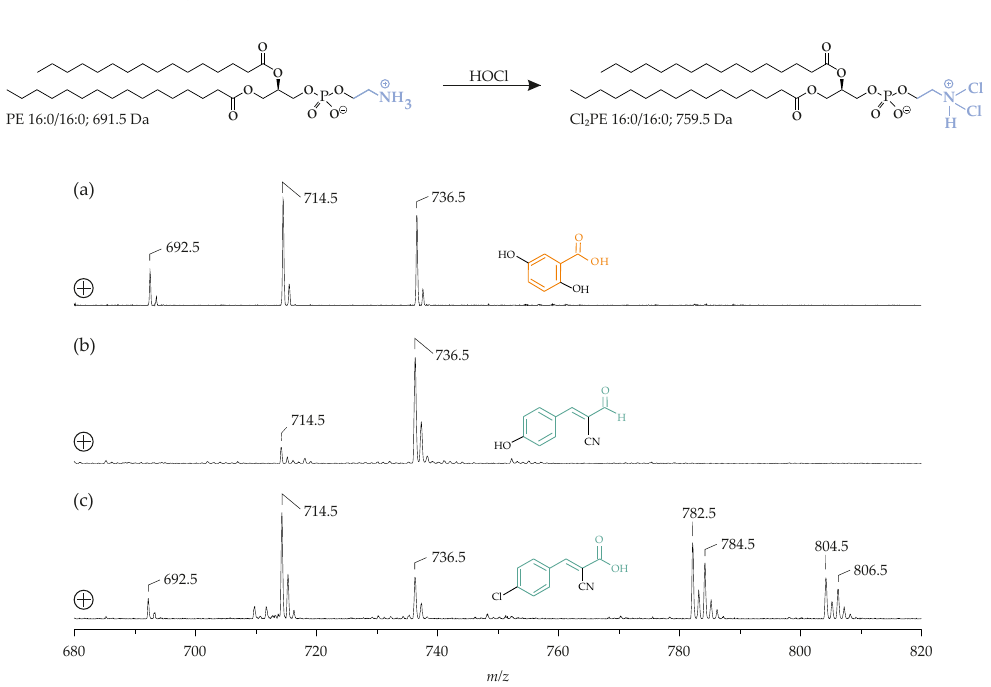
Figure 5. The MALDI-TOF mass spectra (positive ionization mode) of 1,2-dipalmitoyl- sn- phosphatidylethanolamine (PE 16:0/16:0; M = 691.5 g/mol), after treatment with a ten-fold molar excess of hypochlorous acid (HOCl) leading to the dichloramine of PE (Cl 2 PE) 16:0/16:0 using the